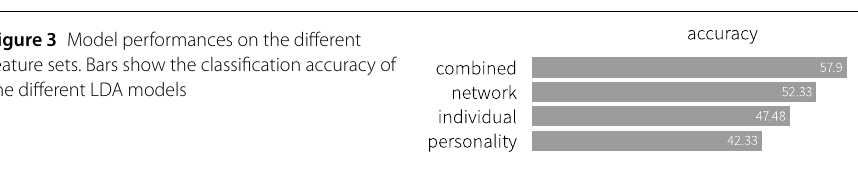
Figure 3 Model performances on the different feature sets. Bars show the classification accuracy of the different LDA